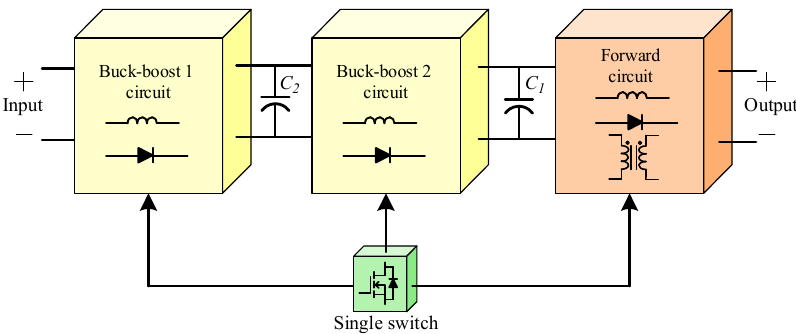
Figure 2. A brief block diagram to illustrate the derivation of the proposed converter.